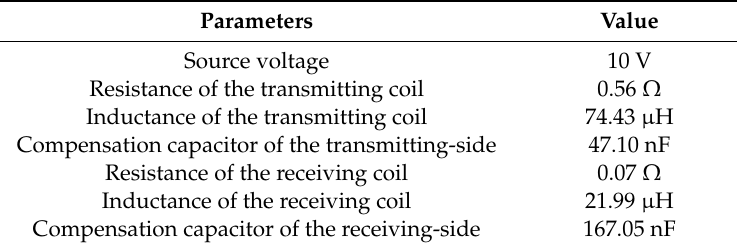
Table 2. Parameters of the experimental